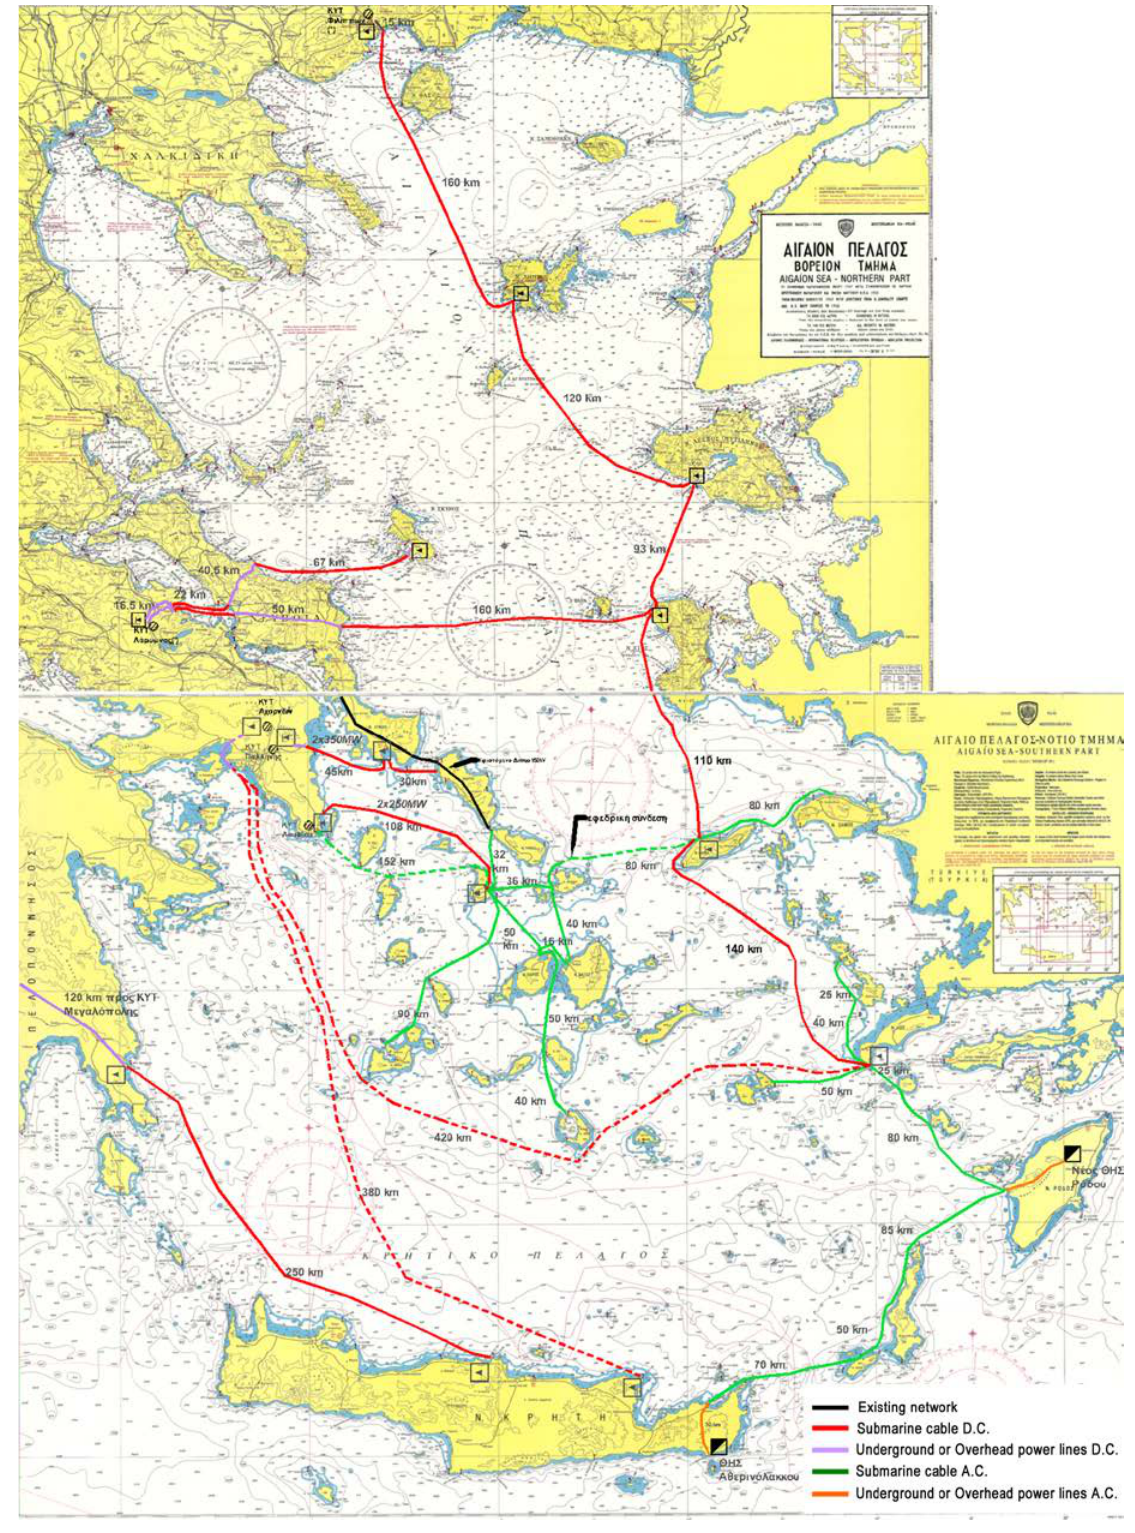
Figure 2. Interconnection proposals for the Aegean Sea Islands [41].